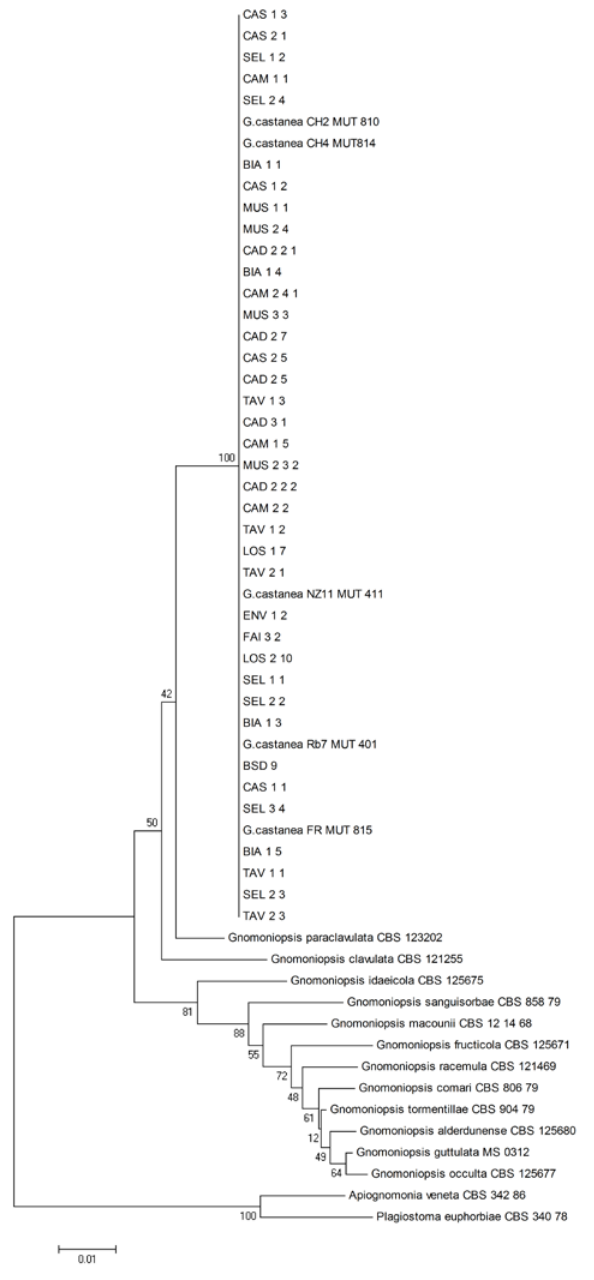
Figure 6. Neighbour-joining tree of ITS sequences.